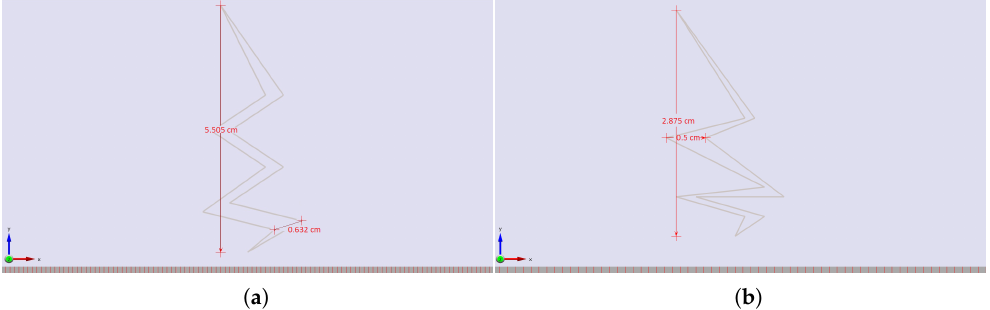
Figure 30. The shape of the cracks: ( a ) the first crack’s shape; ( b ) the second crack’s shape. Figure 31 shows that the length of the rotor blade is 5.715 m, and the distance between the two cracks is 87.90